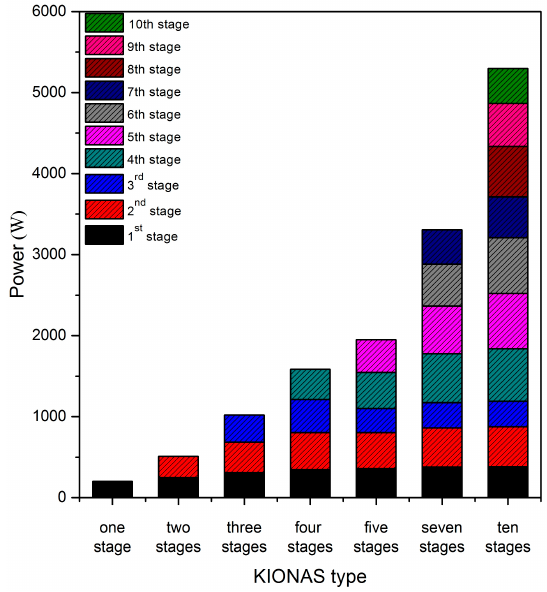
Figure 8. Total power output in Watts for various KIONAS types.